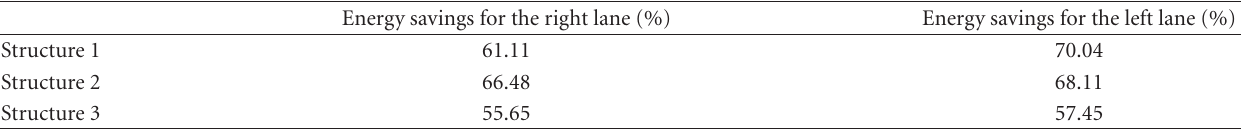
Table 4: Average energy savings, S , (%) under each of the three tension structures. Energy savings for the right lane (%)